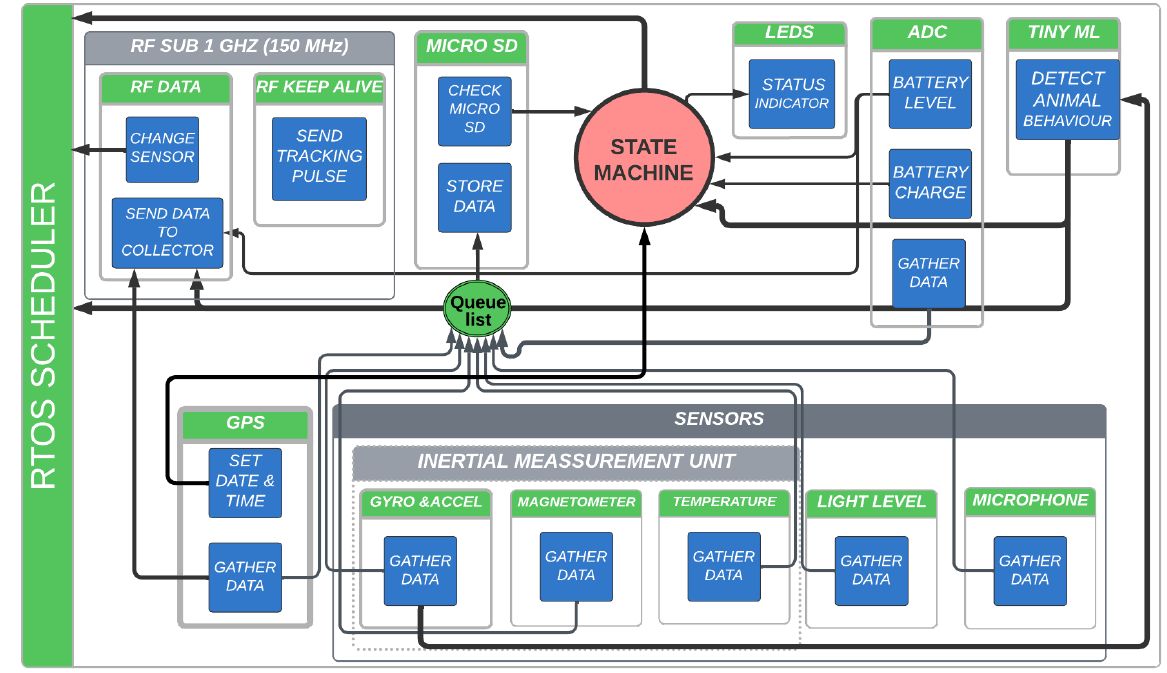
Figure 3. Firmware diagram with the different elements, actions, and tasks of the MD. Elements in light gray show examples of different drivers or objects that are being shared by tasks (such as the RF radio driver or the IMU). Blue squares represent different actions carried out by the RTOS tasks. Elements in green represent a single periodic/pseudo-periodic task being handled by the RTOS (TI-RTOS). The queue list for the micro SD memory card storage action is also managed by the OS. A state machine is an object called by the different tasks without being an autonomous task in